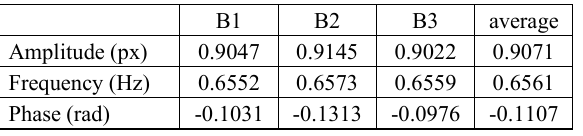
Table 5. Reference values of the jitter curve